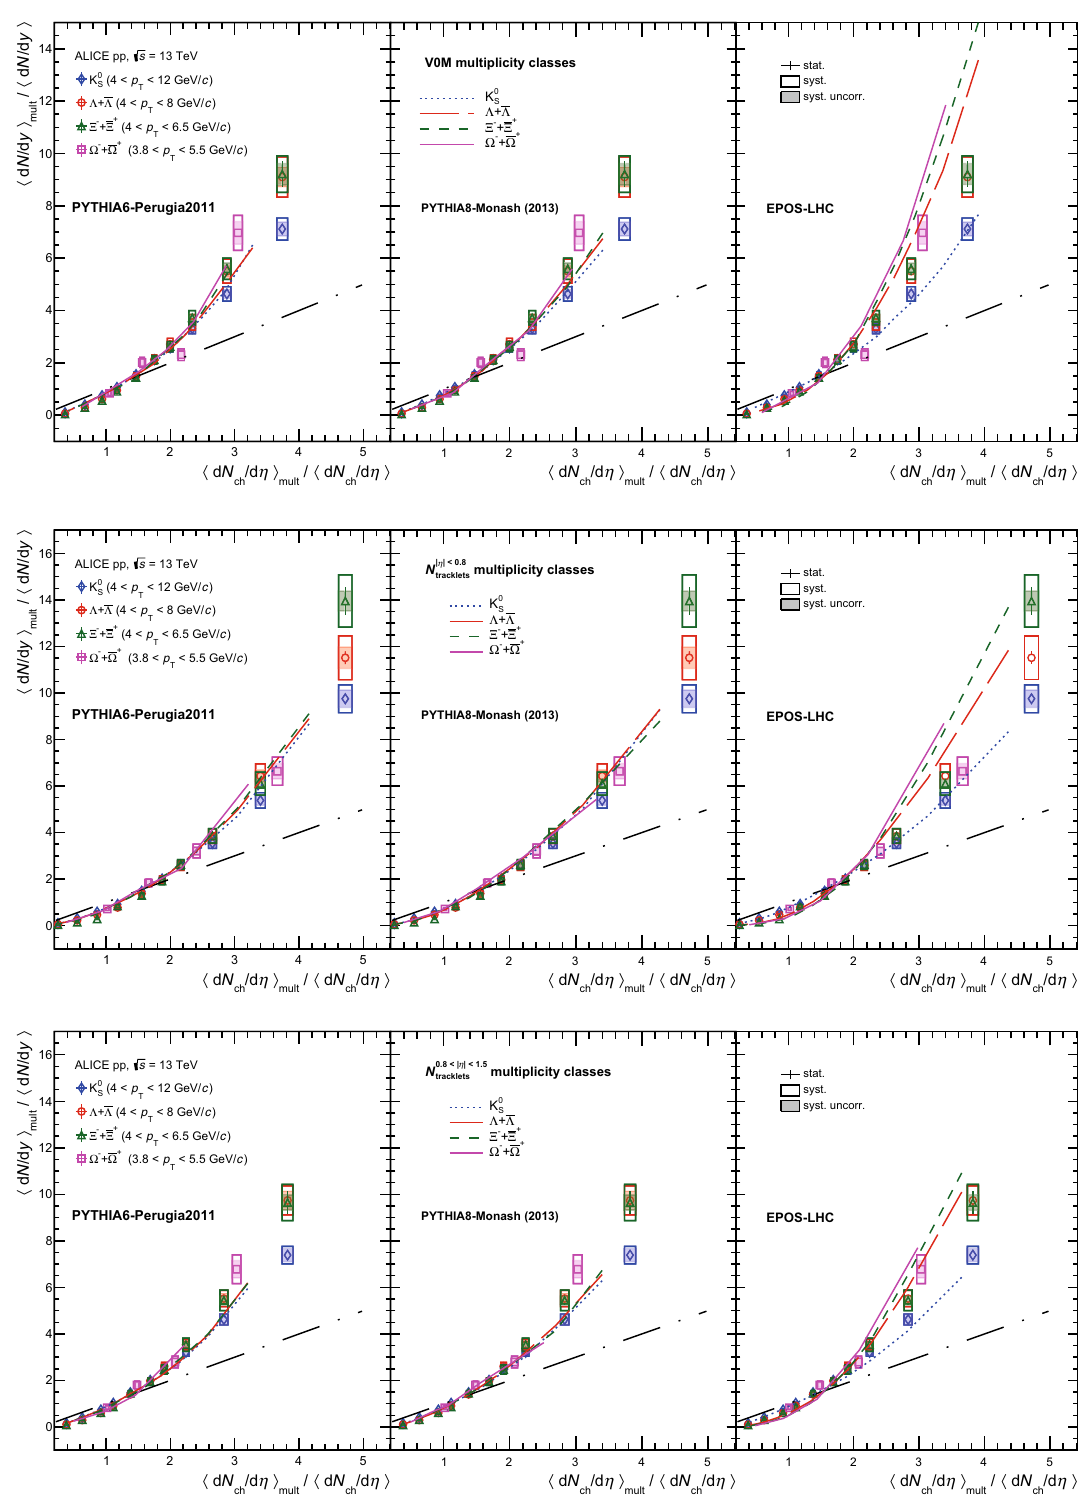
Fig. 6 Self-normalised yields of strange hadrons integrated for p T > 4 GeV / c (3.8 GeV / c for the (cid:5) ) versus the self-normalised charged particle multiplicity quoted using different multiplicity estima- tors (see text for details). Statistical and systematic uncertainties are